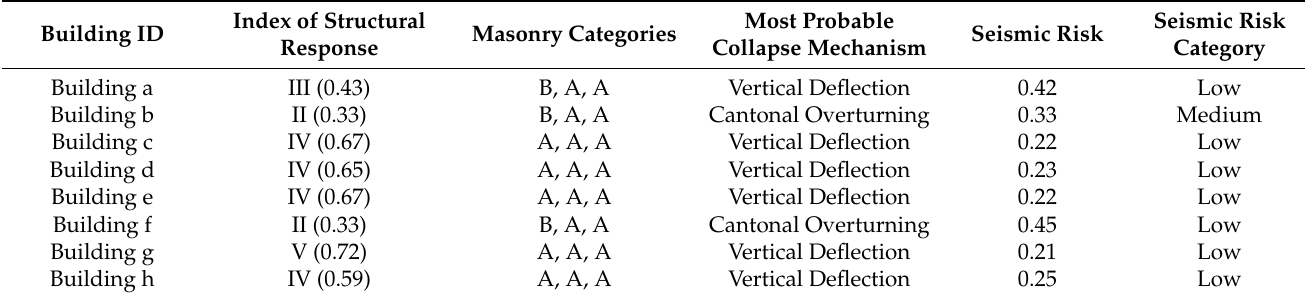
Table 10. Result of the evaluation of buildings in Belgrade,